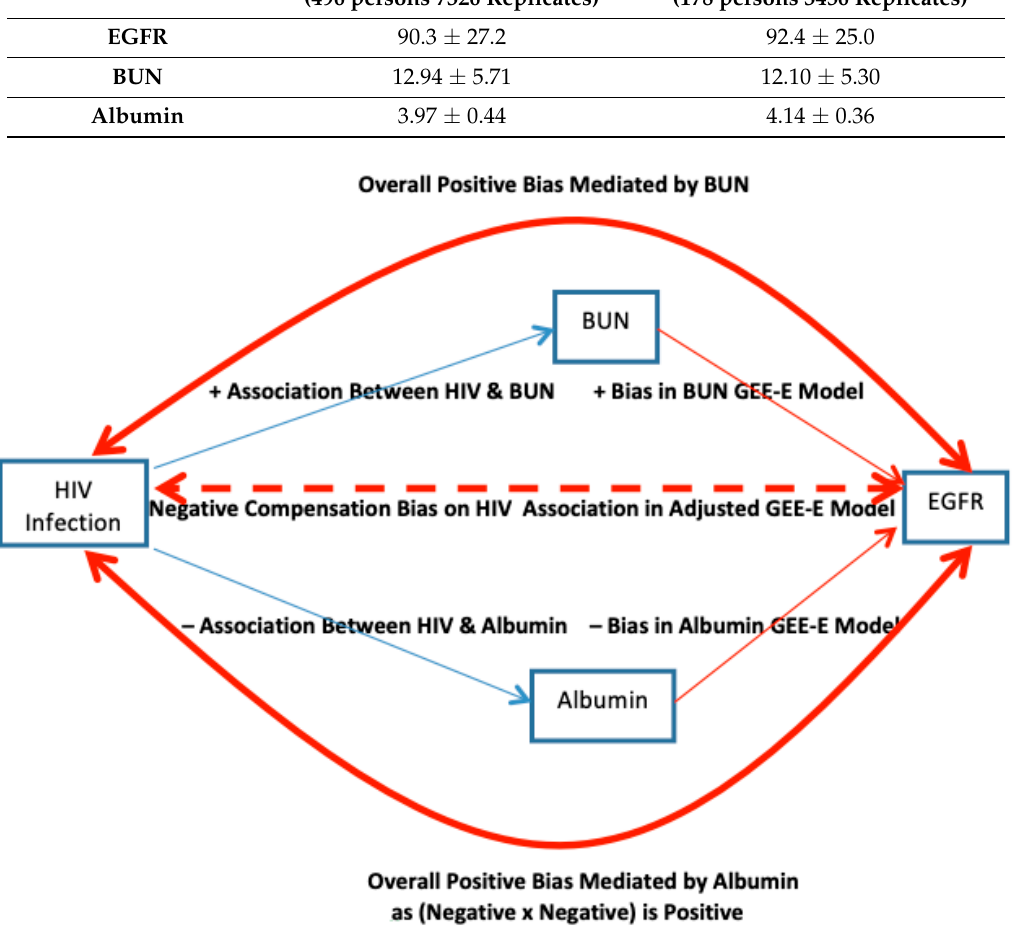
Figure 4. Compensating bias pathways on time invariant HIV estimate from failure to use an independent working correlation structure in repeated measures